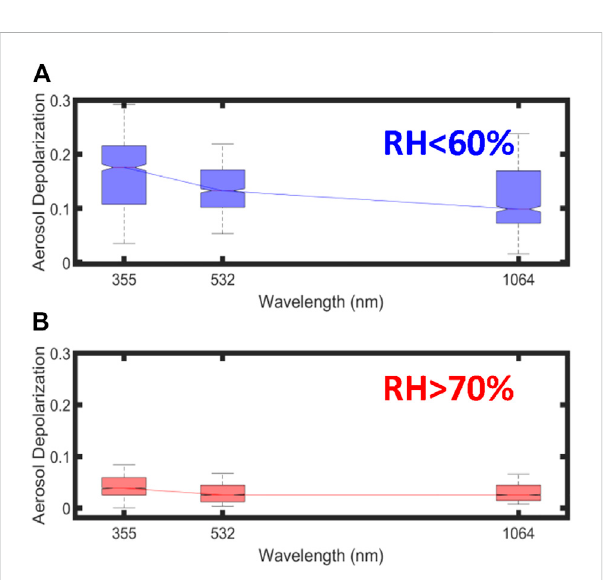
FIGURE 10 Median (line), 25 – 75 percentile (box), and 5 – 95 percentile (bars) aerosol depolarization values for (A) mean dropsonde RH < 60% in the lowest 300 m and (B) mean dropsonde RH > 70% in the lowest 300 m derived from HSRL-2 and dropsonde data collected